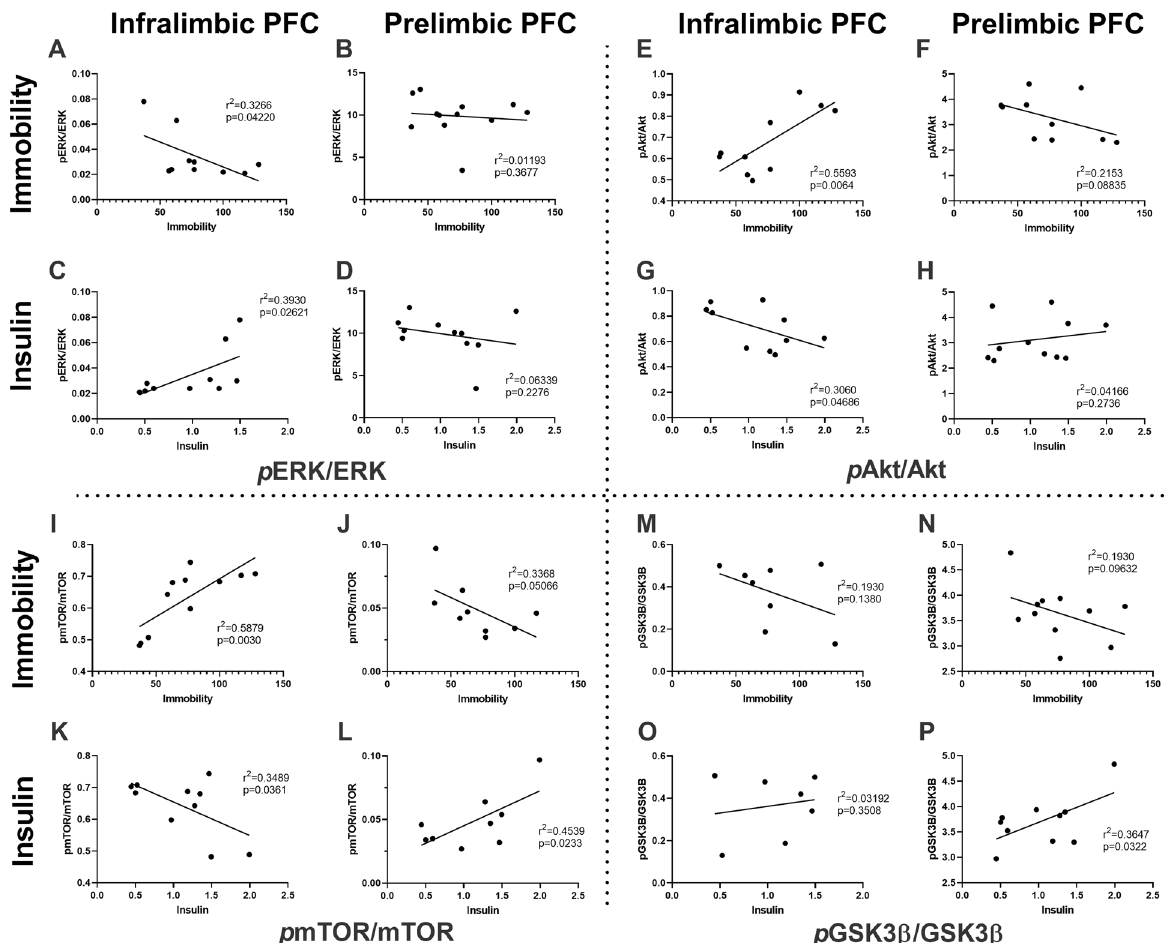
Fig. 6 Correlation between antidepressant-like response or peripheral insulin levels and prefrontal protein expression. The relationship between phosphorylated ( p ) protein expression as a ratio of total protein expression in the infralimbic and prelimbic prefrontal cortex (columns) and time spent immobile in the forced swim test or peripheral blood insulin levels (rows) for extracellular signal-regulated kinases 1/2 (ERK1/2; A – D ); protein kinase B(Akt; E – H ); mammalian target of rapamycin (mTOR; I – L ); and, glycogen synthase kinase-3ß (GSK3ß; M – P